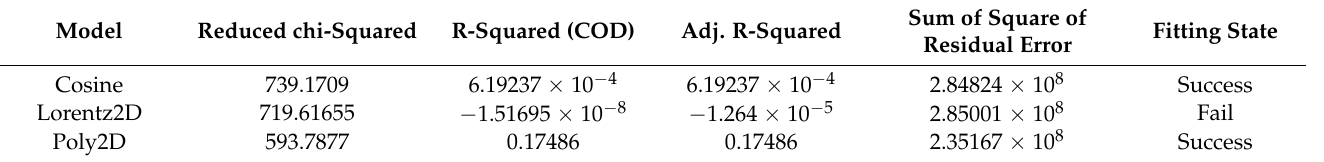
Table 4. Fitting results for slope gradient, azimuth angle and ridge orientation obtained using the Cosine, Lorentz2D and Poly2D models.